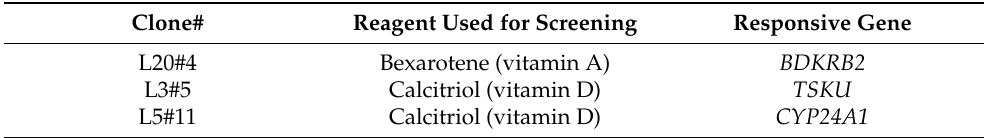
Table 1. List of bexarotene- or calcitriol-responsive reporter cell clones and responsive genes, as revealed by 5 (cid:48) RACE. Clone# Reagent Used for Screening